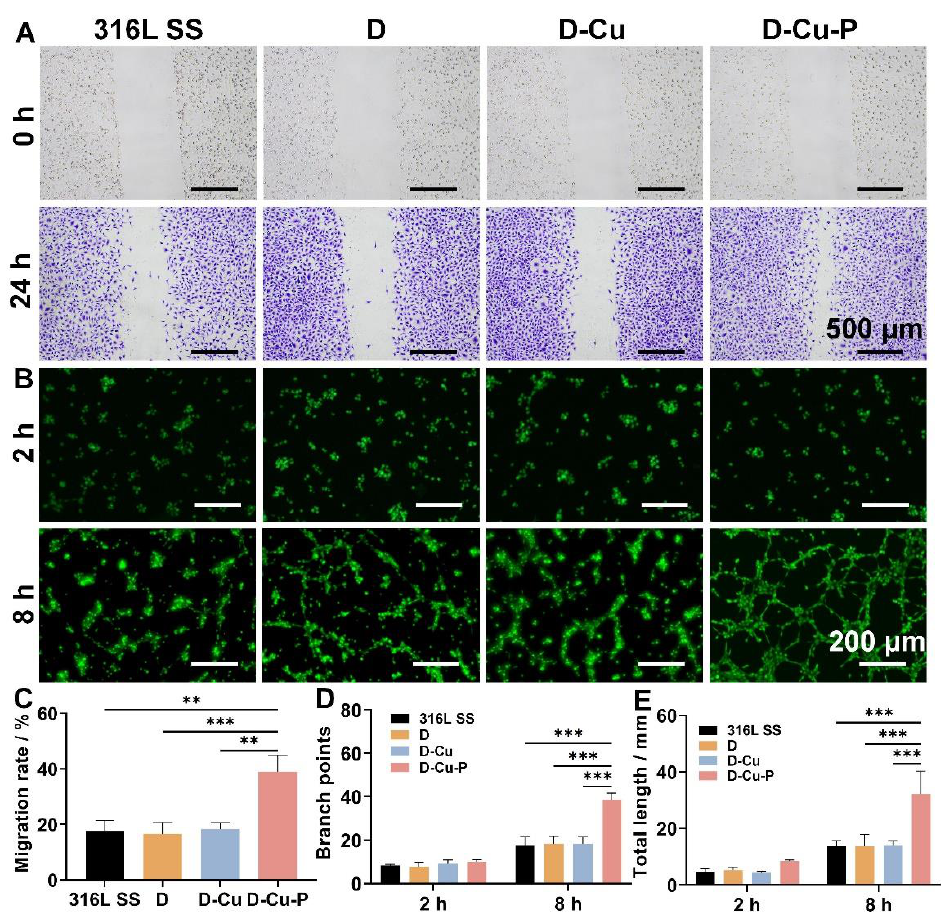
Figure 4. Re-endothelialization capacity evaluations of HUVECs. ( A ) HUVECs migration assay and ( B ) tube formation assay for the different coated samples. ( C ) The quantification of cell migration rate in the migration assay. The quantification of ( D ) branch points and ( E ) total length of tubulars in tube formation assay. ** p < 0.01 and *** p < 0.001 denote the statistical significance.